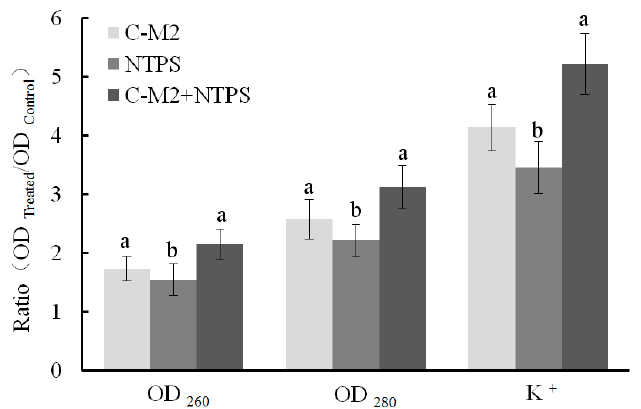
Figure 5. Extracellular UV-absorbing materials and K + released from Morganella sp. wf-1 cells with different treatments. Different lowercase letters (a, b) for the same group indicate significant differences ( p < 0.05).